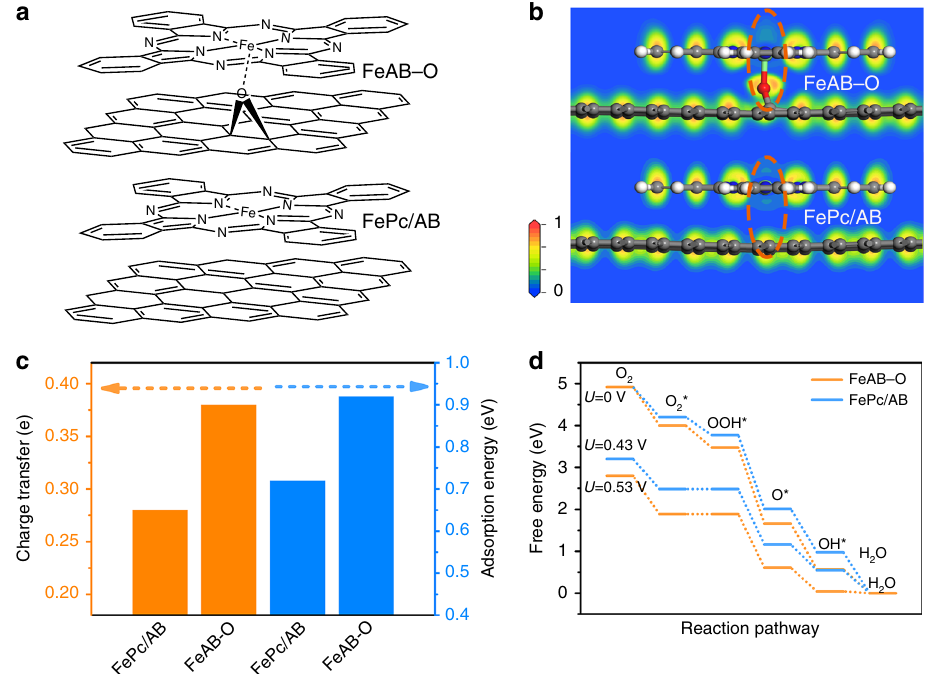
Fig. 1 Theoretical calculations. a Molecular structure models. b Electron localization functions and c Bader charge transfers and the O 2 adsorption energies of FeAB – O and FePc/AB. d Free energy diagrams of ORR pathways on FeAB – O and FePc/AB.